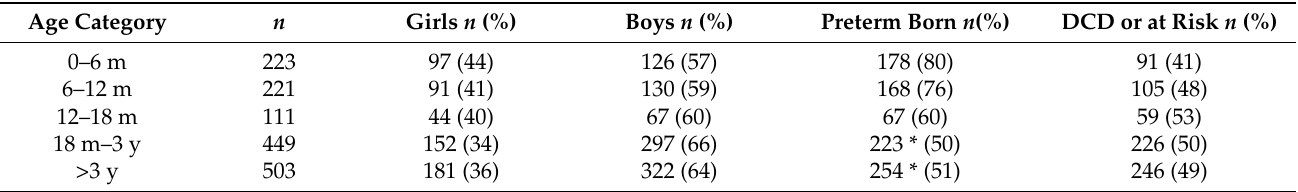
Table 1. Number of assessed children by age group, gender, corresponding number of children born at preterm age, and number of children with a subsequent clinical DCD or at-risk DCD diagnosis after three years.